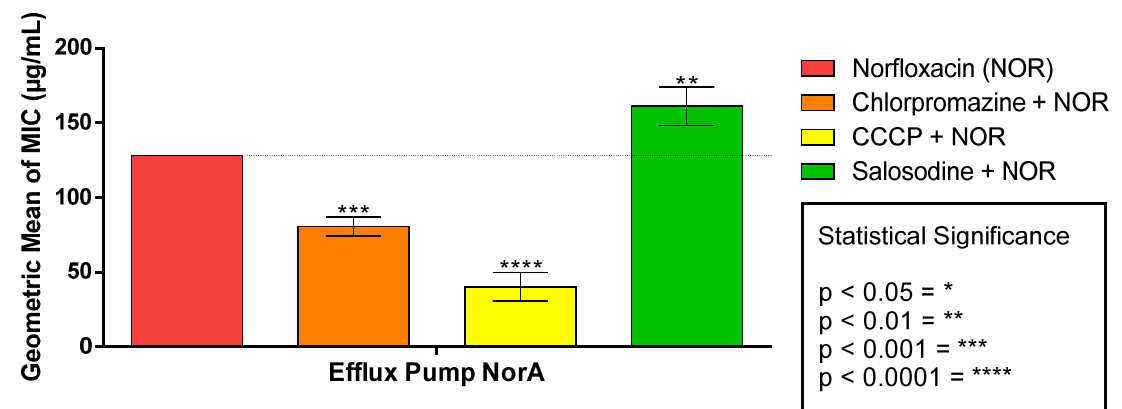
Figure 2. Modifying effect of norfloxacin antibiotic action by solasodine on S. aureus strain 1199B.